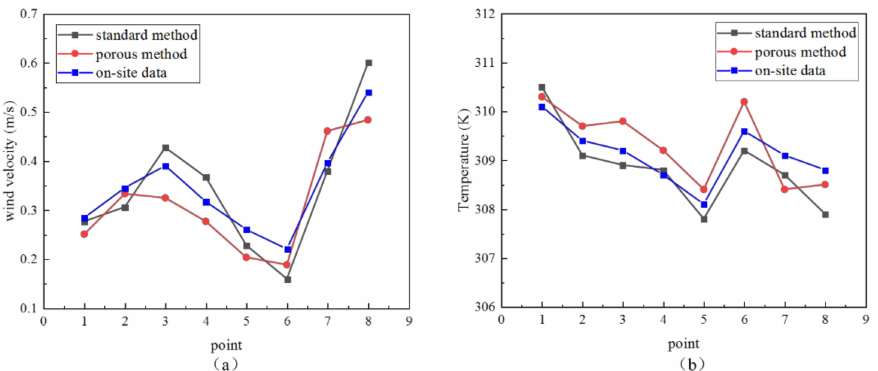
Figure 9. Comparison of measured and simulated ( a ) wind velocity and ( b ) temperature at different points.